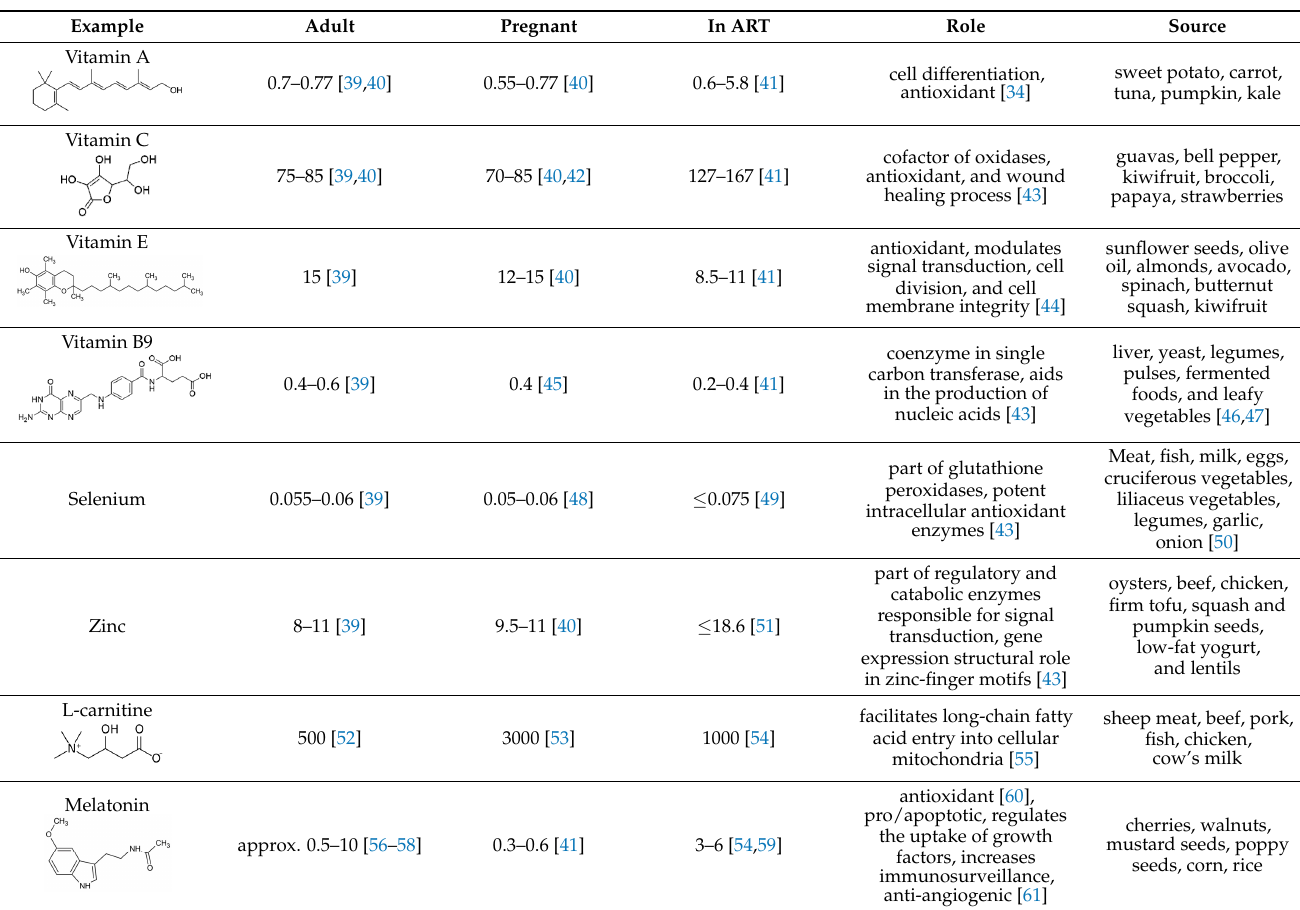
Table 1. Recommended daily supplementation dose of some naturally occurring antioxidants for women in different cases (ARD mg/day).